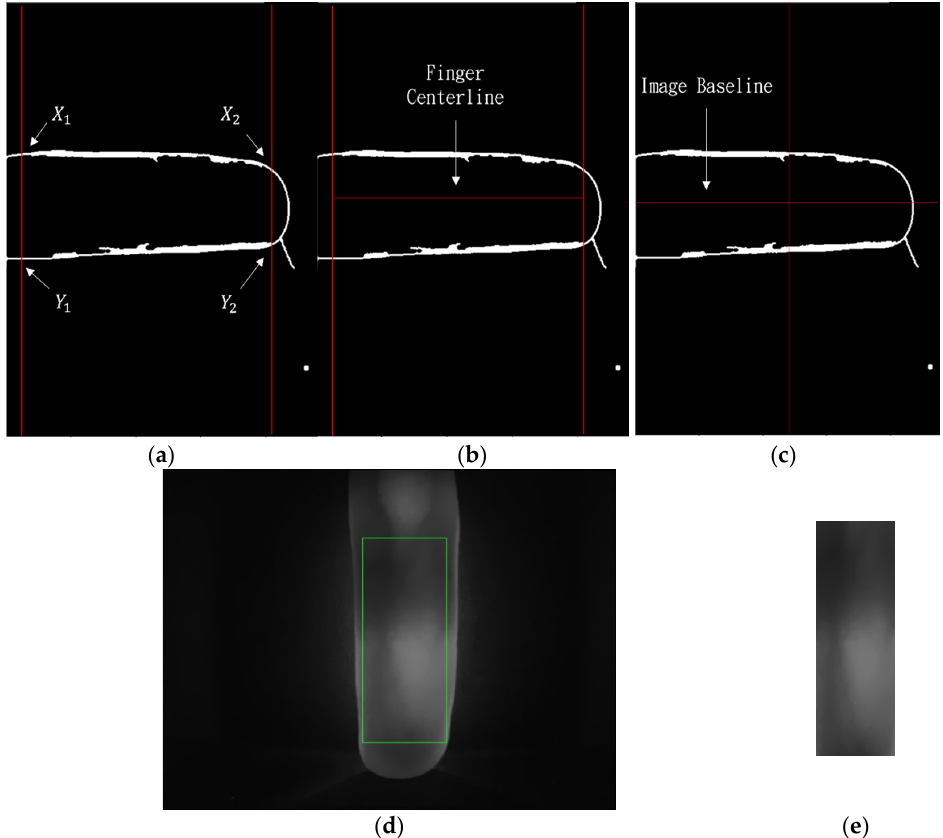
Figure 5. ROI detection: ( a ) Left and right half coordinates; ( b ) Inherent finger center baseline; ( c ) Calculated center baseline; ( d ) Extracted ROI image. ( e ) Normalized image.